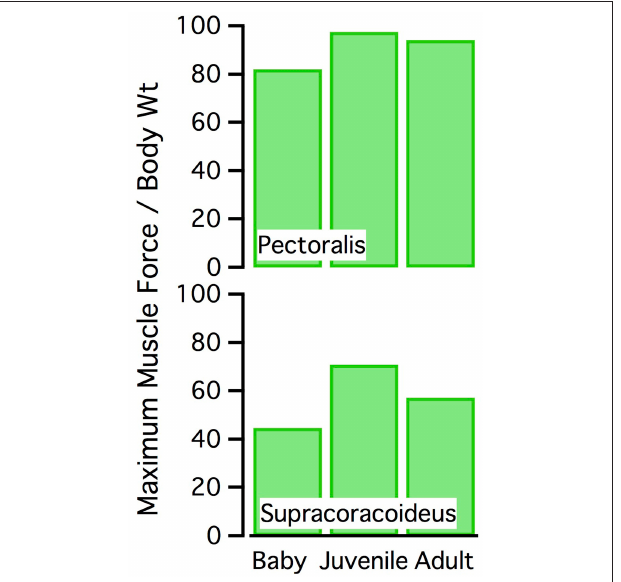
FIGURE 10 | Normalized muscle force. Maximum isometric muscle force as a percentage of body weight, for the pectoralis and supracoracoideus (both sides of the body). The juvenile model has the highest maximum force, for its body size.